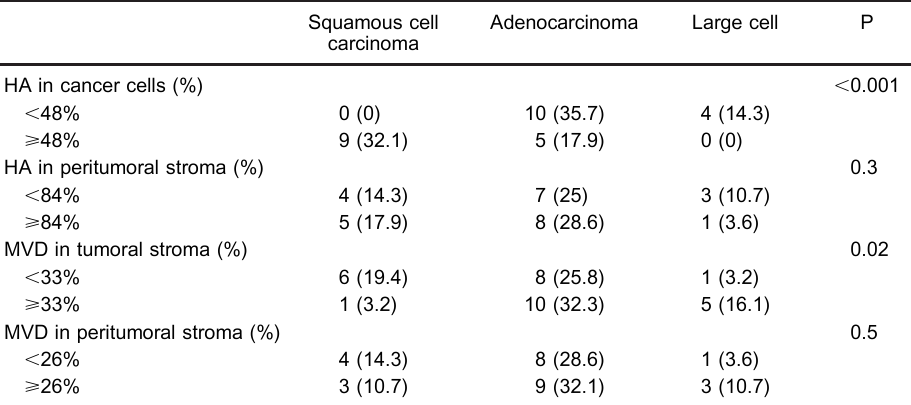
Table 2. Immunohistochemistry analysis and distribution of hyaluronan (HA) and microvessel density (MVD) in cancer cells, stroma and peritumoral stroma stratified according to histologic types of lung cancer. Squamous cell carcinoma